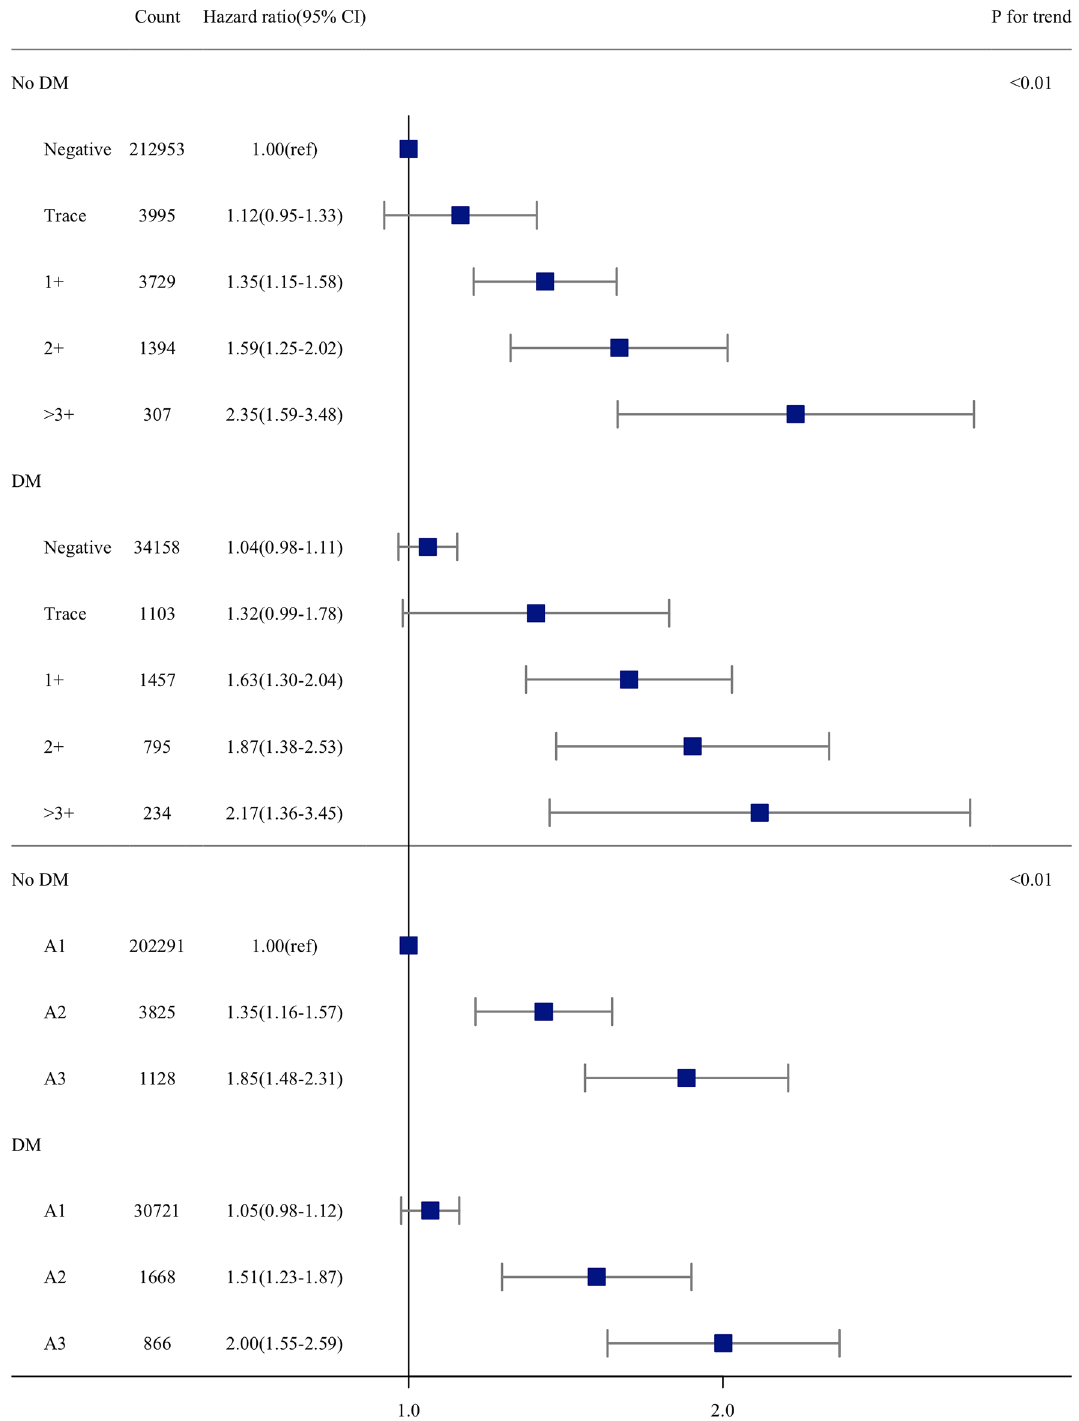
Figure 3. Hazard ratio for incident atrial fibrillation according to the degree of proteinuria by dipstick test and predicted albumin-creatinine ratio. Boxes indicate the hazard ratio, limit lines indicate the 95% confidence interval, and the vertical line (at hazard ratio 1) indicates no difference in the hazard ratios between atrial fibrillation and no atrial fibrillation. A1, predicted albumin-to-creatinine ratio, < 30 mg/g; A2, predicted albumin-to-creatinine ratio, 30–300 mg/g; A3 predicted albumin-to-creatinine ratio, > 300